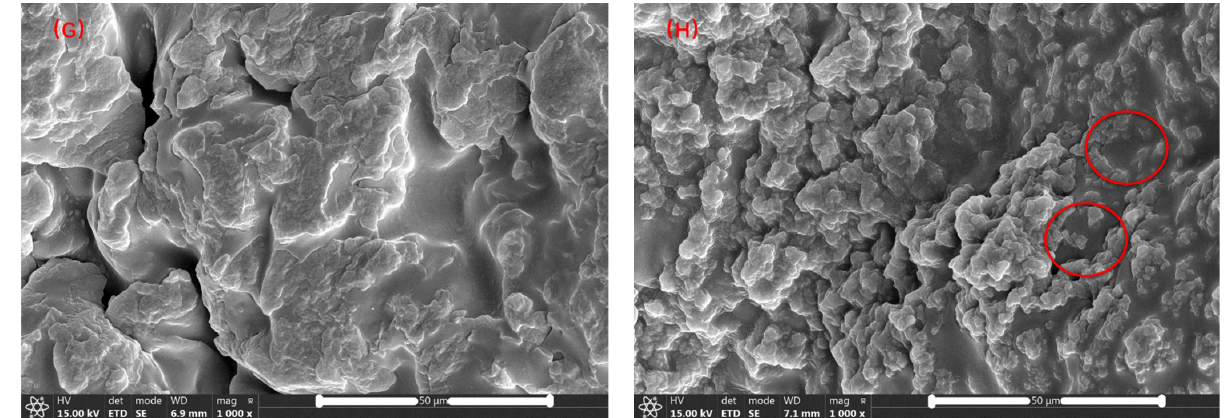
Figure 4. SEM diagrams obtained by etching method ( A – H ) correspond to samples 1–8, respectively.